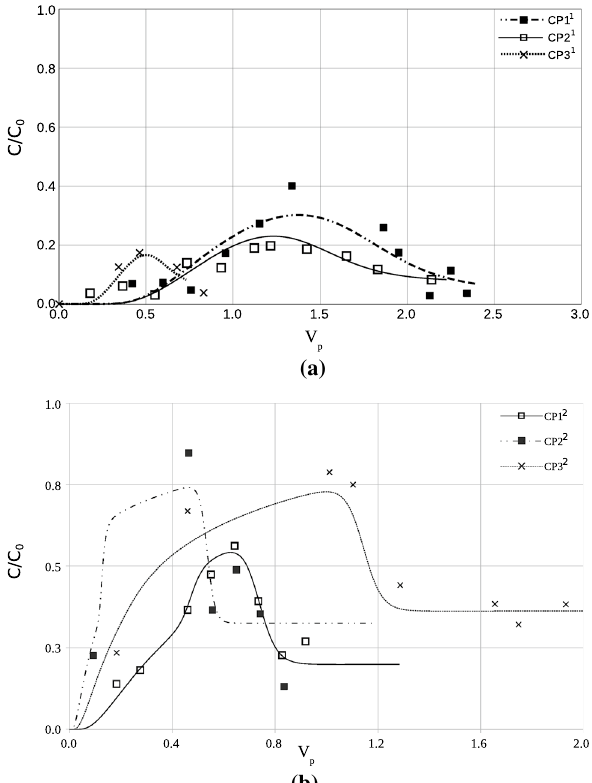
Figure 5. Experimental and fitted breakthrough curves. ( a ) First sampling campaign and ( b ) second sampling campaign.